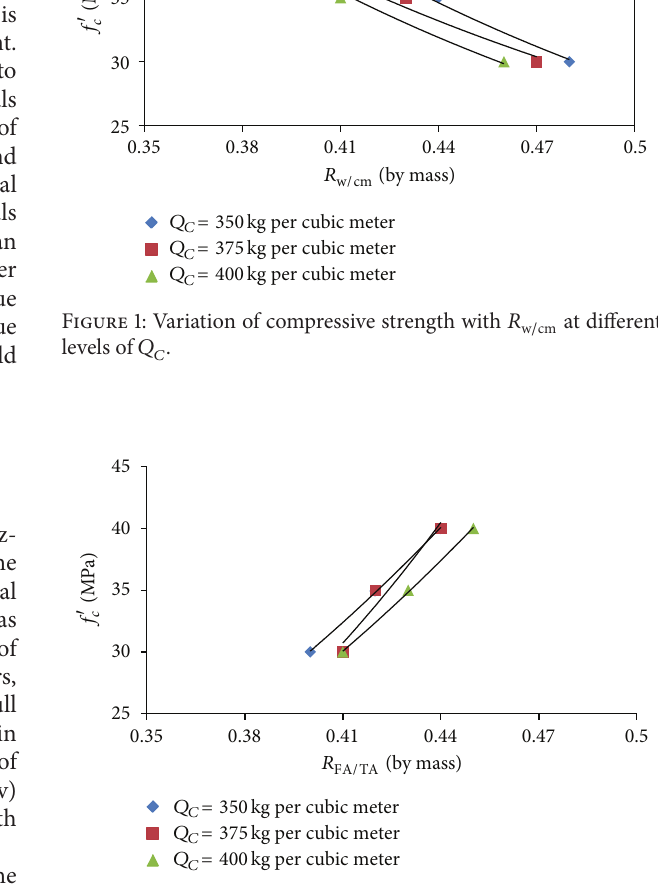
at different levels FA / TA